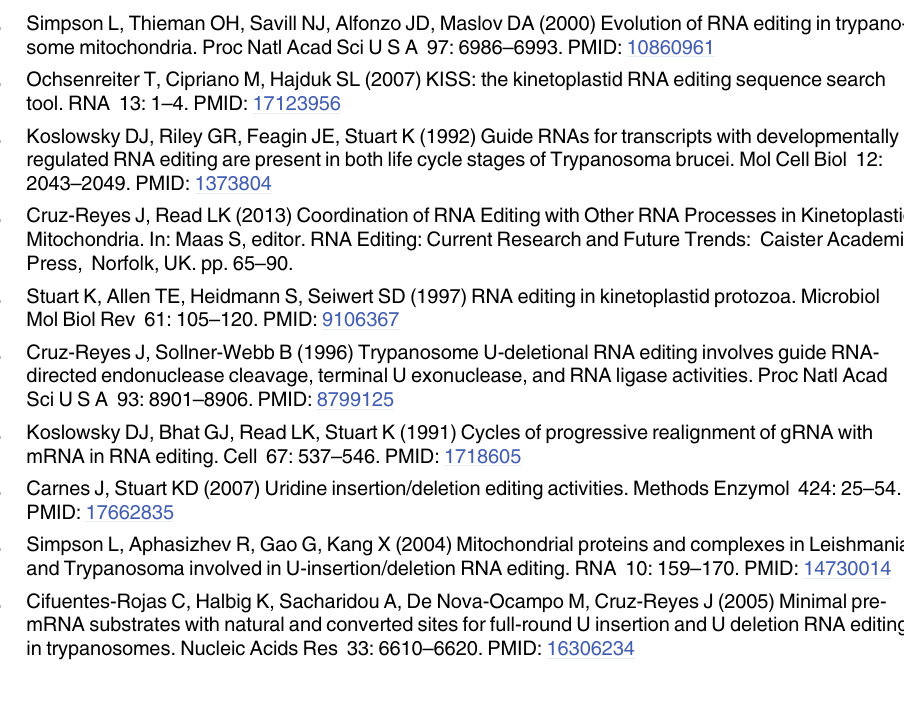
S1 Table. Oligonucleotide primers designed in this study. We designed the indicated primers to perform RT-qPCR of 3 ’ early editing sites, manual sequencing of block 1 sites, RT-PCR of the first ~200 bp of editing domain (A6 and ND7), RNA interference (RNAi), point mutations and generation of photo-reactive gA6 B1.alt. RT-PCR primers to amplify the entire RPS12 were as in